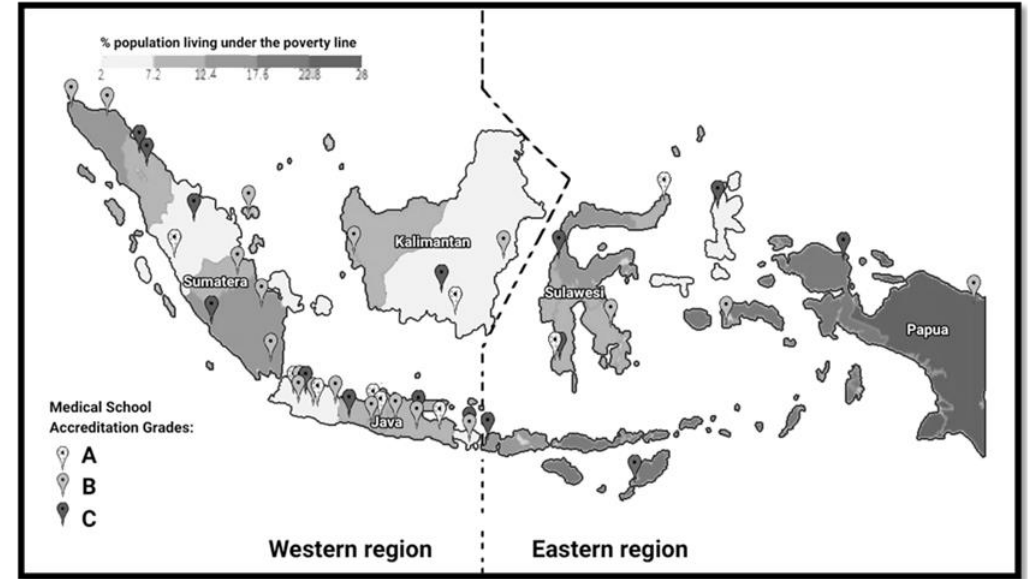
Figure 2. Distribution of all medical schools across the Eastern and Western regions of Indonesia and percent population living under the poverty line [14,17].